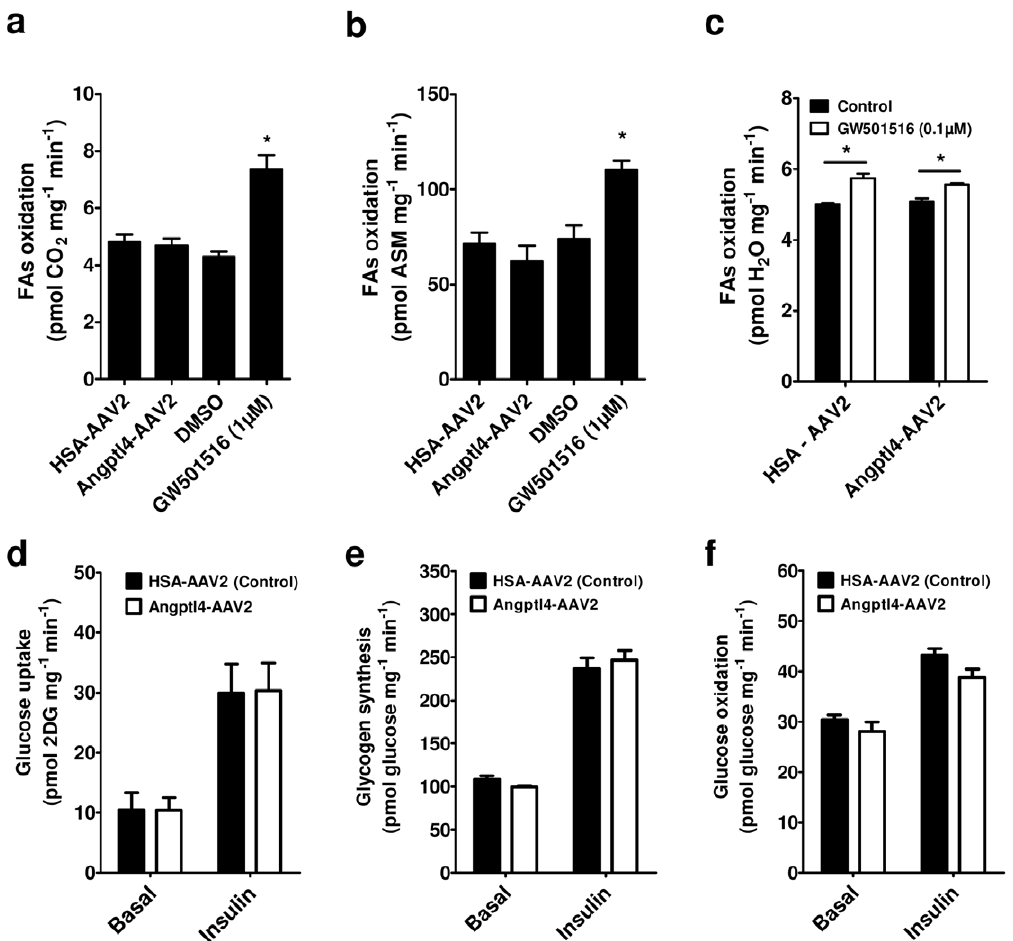
Figure 8. Angptl4 overexpression has no effect on fatty acids oxidation and glucose metabolism in L6 myotubes. Fatty acid (palmitate) oxidation was evaluated by measuring ( a ) 14 C-CO 2 or ( b ) 14 C-acid soluble metabolites ( 14 C-ASM) production in L6 myotubes 72 hours post-infection with HSA-AAV2 (Control) or Angptl4-AAV2 and compared with cells incubated with DMSO (Control) or GW501516 for 24 hours, n=3. ( c ) Palmitate oxidation was evaluated by measuring 3 H-H 2 O released from myotubes incubated with low doses of GW501516 in the setting of low (HSA-AAV2) and high (Angptl4-AAV2) Angptl4 levels, n=4. ( d ) Glucose uptake, ( e ) glycogen synthesis and ( f ) glucose oxidation were measured in L6 myotubes 72 hours post-infection with HSA-AAV2 or Angptl4-AAV2 in the absence (Basal) or presence of insulin (100 nM), n=3. *p , 0.05, One-way ( a, b ) or Two-way ( c–f ) ANOVA with Bonferroni post-tests.